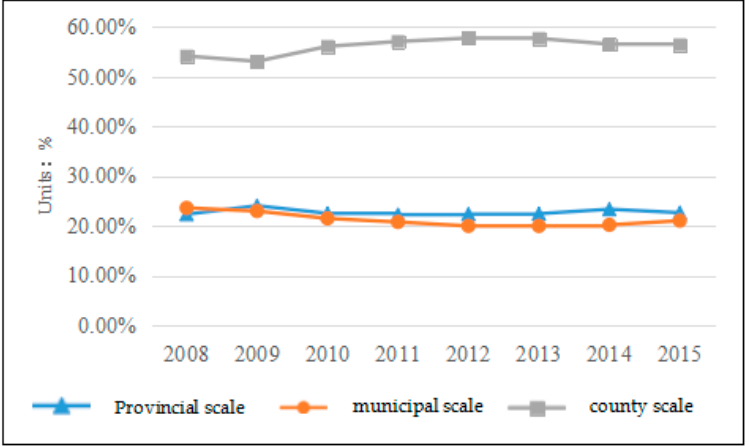
Figure 3. Scale variance decomposition of different scales of the Yangtze River Delta in 2008–2015.